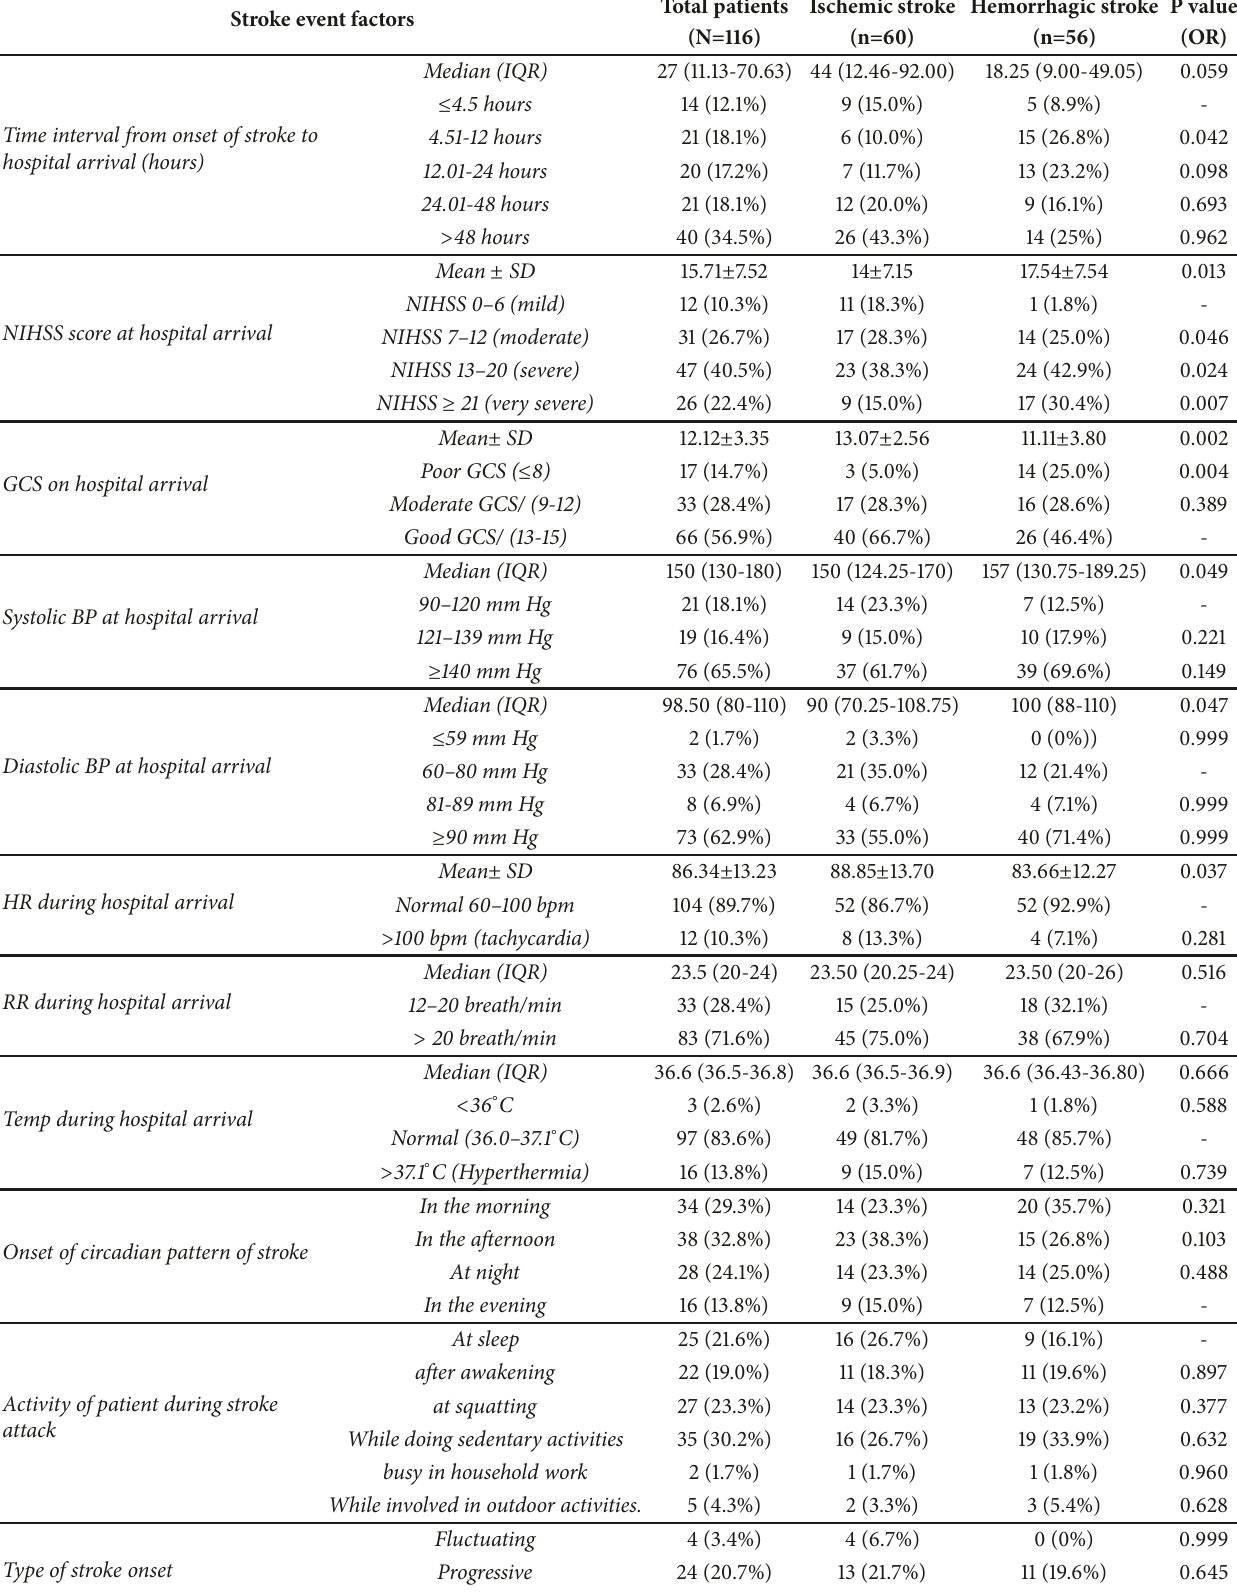
Table 2: Stroke event factors among adult stroke patients admitted to stroke unit of JUMC from March 10 and July 10,